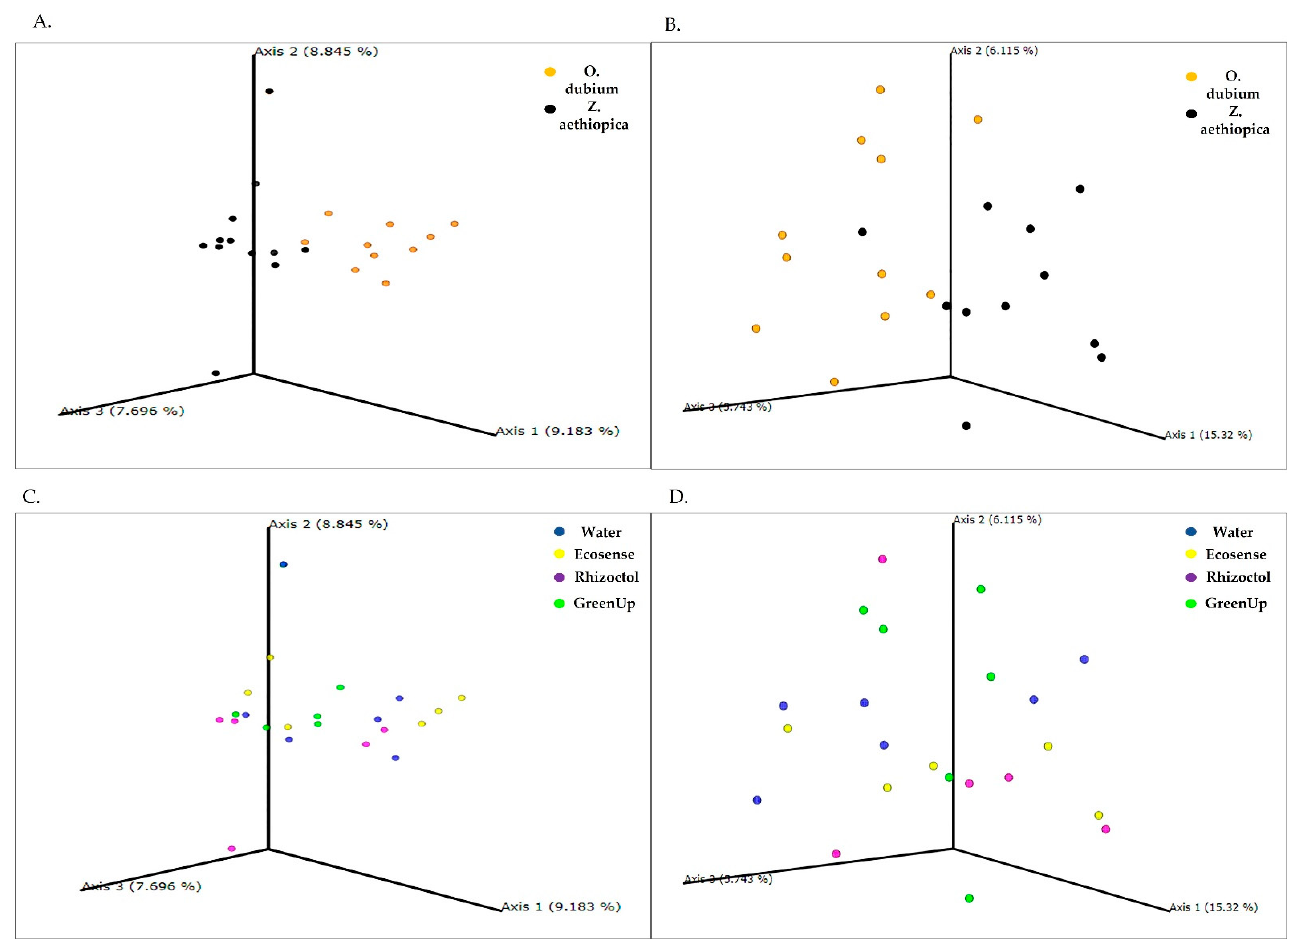
Figure 5. Principal-coordinates analysis (PCoA) plots of unweighted Unifrac distance metrics of bacterial populations in the root-associated environments of Ornithogalum dubium and Zantedeschia aethiopica . Data for each year were analyzed separately. ( A ) The different plant species in perlite: O. dubium in orange; Z. aethiopica in black. ( B ) The different plant species in the planting mix: O. dubium in orange; Z. aethiopica in black. ( C ) Different growth-promoter treatments applied to plants grown in perlite: water (control; blue), Ecosense (yellow), Rhizoctol (purple) and GreenUp (green). ( D ) Different growth-promoter treatments applied to plants grown in planting mix: water (control; blue), Ecosense (yellow), Rhizoctol (purple) and GreenUp, (green). Each data point represents sequences from a single soil sample; each plot contains all of the samples collected during that growing season.